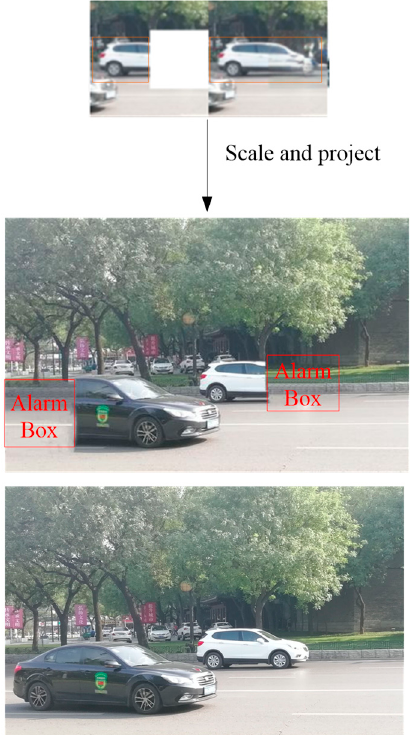
Figure 7. Scaling and projecting to the original image and setting the alarm box.